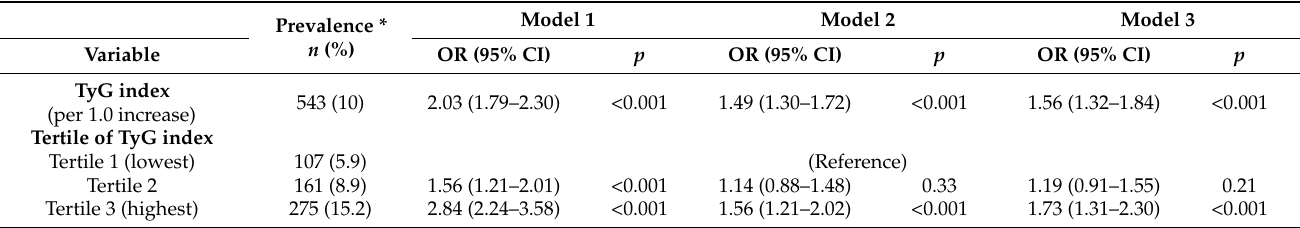
Figure 2. Cubic spline curves for the risk of albuminuria according to TyG index in total study participants ( A ) and participants with RHF ( B ) or without RHF ( C ). Black lines show ORs per 1.0 increase of TyG index and gray dashed lines represent 95% CIs. Abbreviations: TyG index—triglyceride glucose index; RHF—renal hyperfiltration; OR—odds ratio; CI—confidence interval. Table 3. Logistic regression analyses for RHF according to TyG